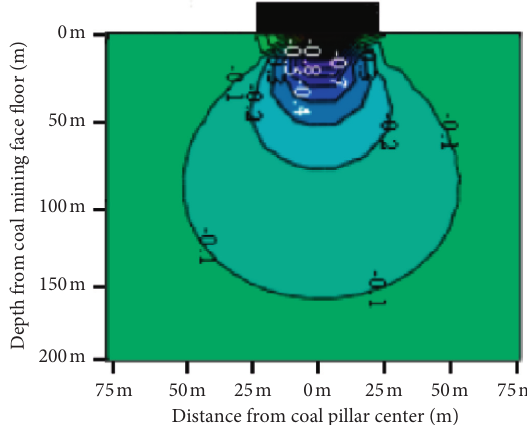
Figure 3: Vertical stress distribution at the bottom of strip coal